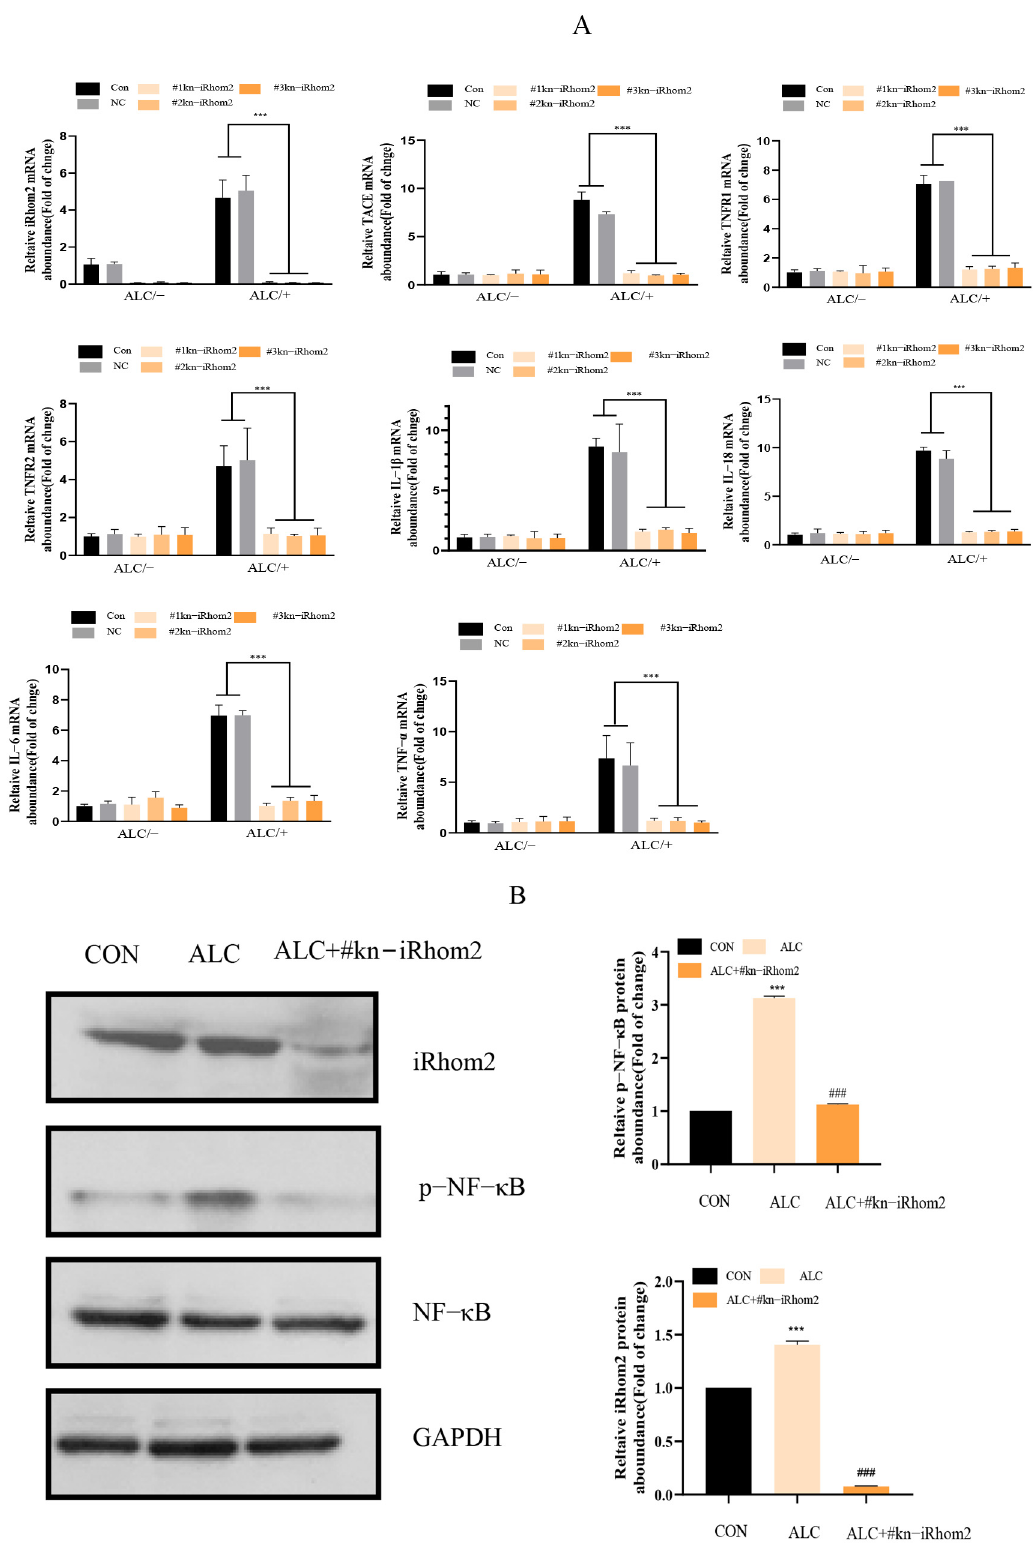
Figure 2. The qPCR showing that the knockout of iRhom2 suppressed the transcriptional expression of iRhom2, TNFR1, 2, IL-1 β , IL-6, IL-18, TNF- α , and TACE mRNA in L02 cells exposed to alcohol ( A ); WB showing that the knockout of iRhom2 decreased the expression of iRhom2 and the phosphorylation of NF- κ B in L02 cells induced by treatment with alcohol ( B ); The data are expressed as the mean value ± SD ( n = 6). *** p < 0.001 vs. the control group (CON and NC group). ### p < 0.001 vs. the ALC group.